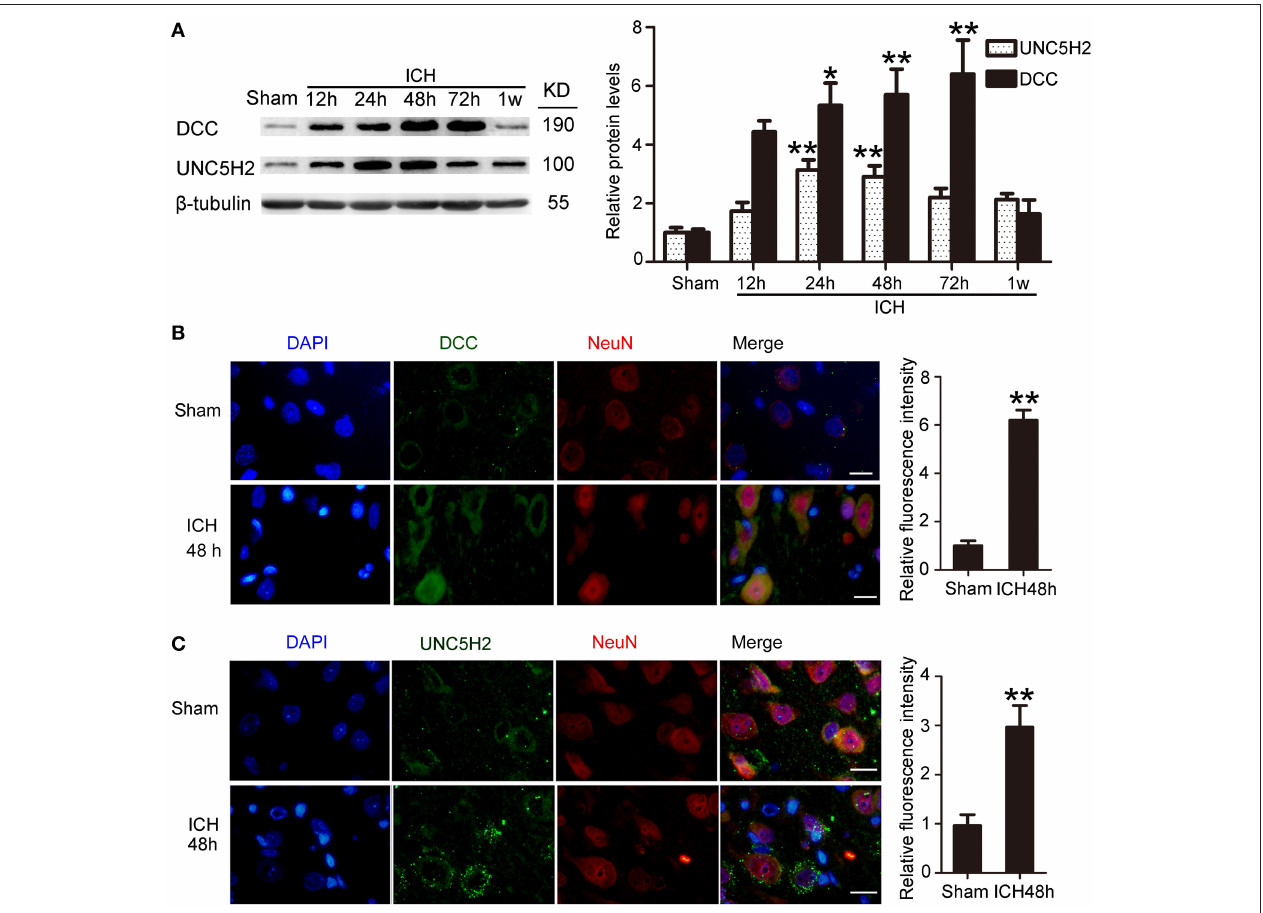
FIGURE 3 | Protein levels and localization of DCC and UNC5H2 after ICH. (A) Western blot assay of protein levels of DCC and UNC5H2 in the peri-hematoma cortex at different time points after ICH. All values are expressed as mean ± SEM. Mean values of protein levels in the sham group were normalized to 1.0. * p < 0.05, ** p < 0.01 vs. the sham group, n = 6. (B) Double immunofluorescence staining was performed in the peri-hematoma cortex with DCC antibody (green) and a neuronal marker (NeuN, red), and nuclei were labeled with DAPI (blue). Scale bar = 20 µ m. All values are expressed as mean ± SEM. The mean value of the sham group was normalized to 1.0. ** p < 0.01 vs. the sham group, n = 6. (C) Double immunofluorescence staining was performed in the peri-hematoma cortex with UNC5H2 antibody (green) and a neuronal marker (NeuN, red), and nuclei were labeled with DAPI (blue). Scale bar = 20 µ m. All values are expressed as mean ± SEM. The mean value of the sham group was normalized to 1.0. ** p < 0.01 vs. the sham group, n =